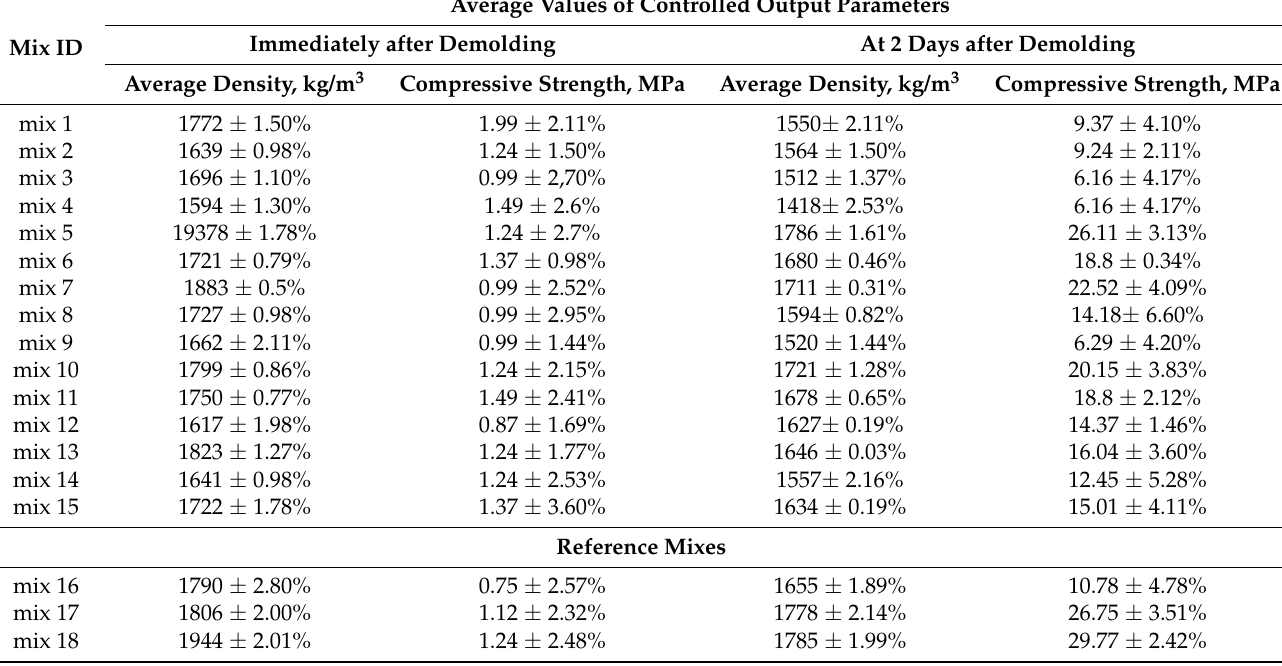
Table 2. Physical and mechanical characteristics of experimental